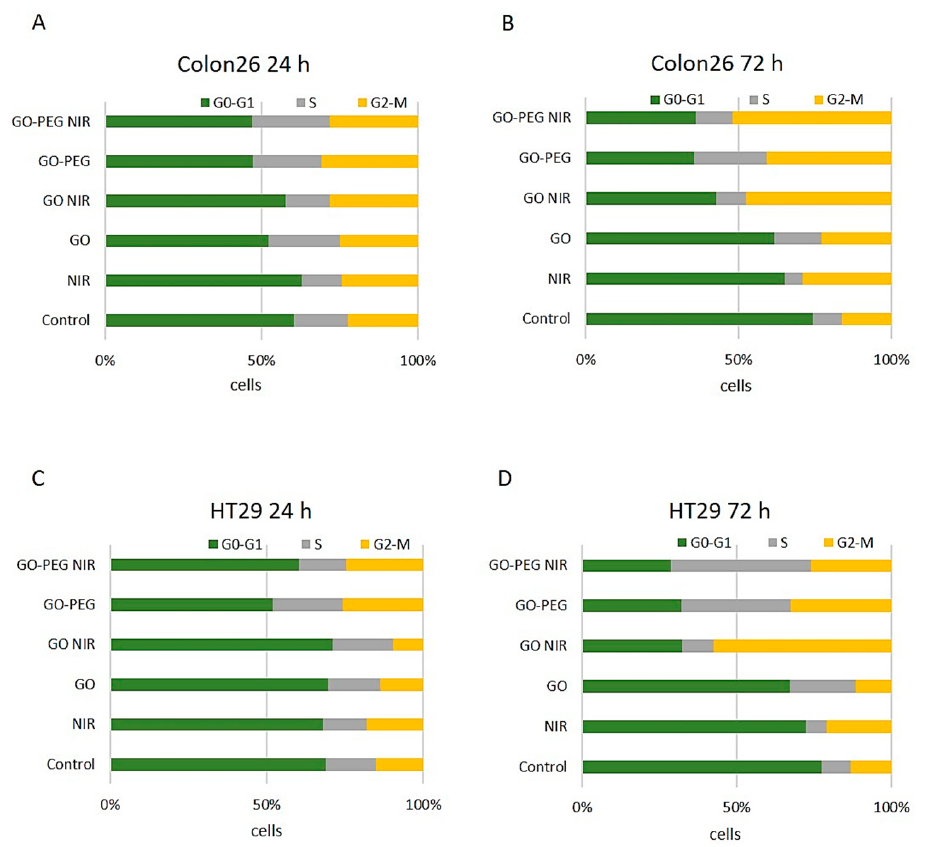
Figure 5. Cell cycle analysis of Colon26 and HT29 cells after PI staining and treatment with GO and GO–PEG NPs with and without NIR via FACS. ( A ) Distribution of Colon26 cells cultivated for 24 h in the presence of NPs with and without NIR irradiation in the cell cycle phases. ( B ) Distribution of Colon26 cells cultivated for 72 h in the cell cycle phases. ( C ) Distribution of HT29 cells cultivated for 24 h in the presence of NPs with and without NIR irradiation in the cell cycle phases. ( D ) Distribution of HT29 cells cultivated for 72 h in the cell cycle phases. Values are MEAN of % of cells from three repetitions.